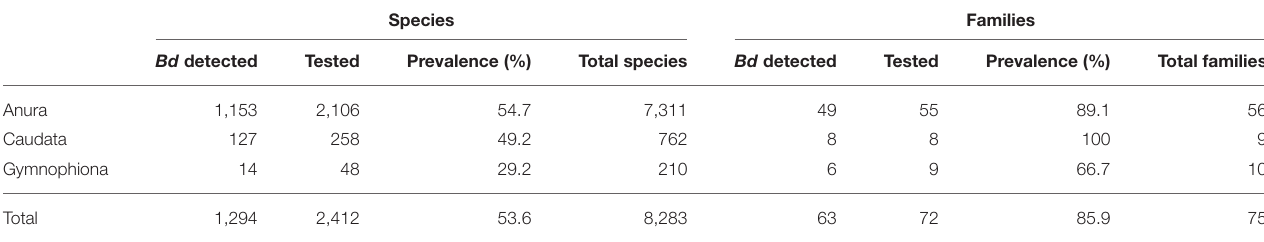
TABLE 2 | Global Batrachochytrium dendrobatidis ( Bd ) detections in amphibians as compiled through December